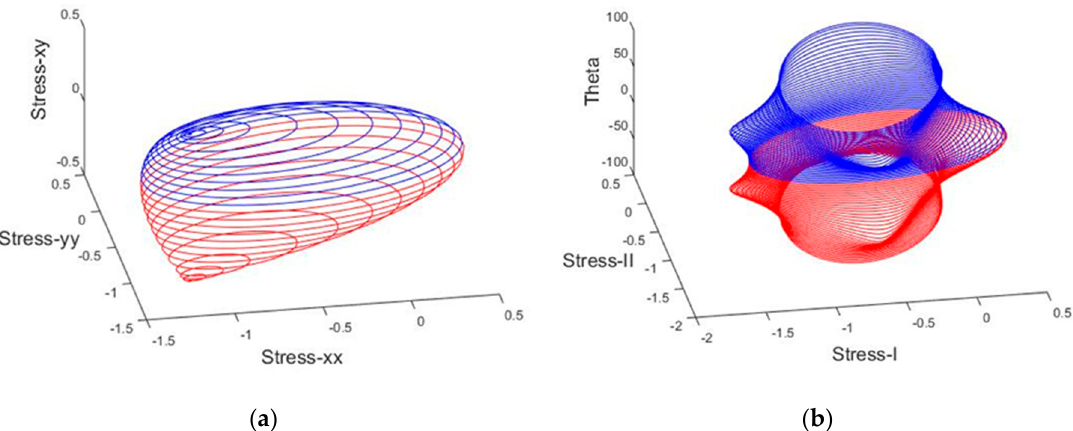
Figure 9. Dimensionless failure surface of masonry material using the cubic tensor polynomial failure criterion: ( a ) non-dimensionless normal stress terms; and ( b ) non-dimensionless principal stress terms.